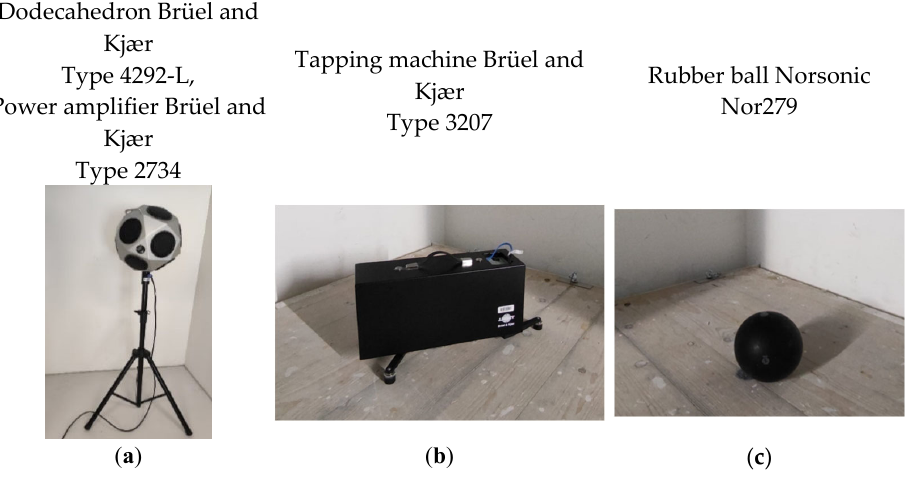
Figure 3. Airborne noise source ( a ), tapping machine ( b ) and rubber ball ( c ).